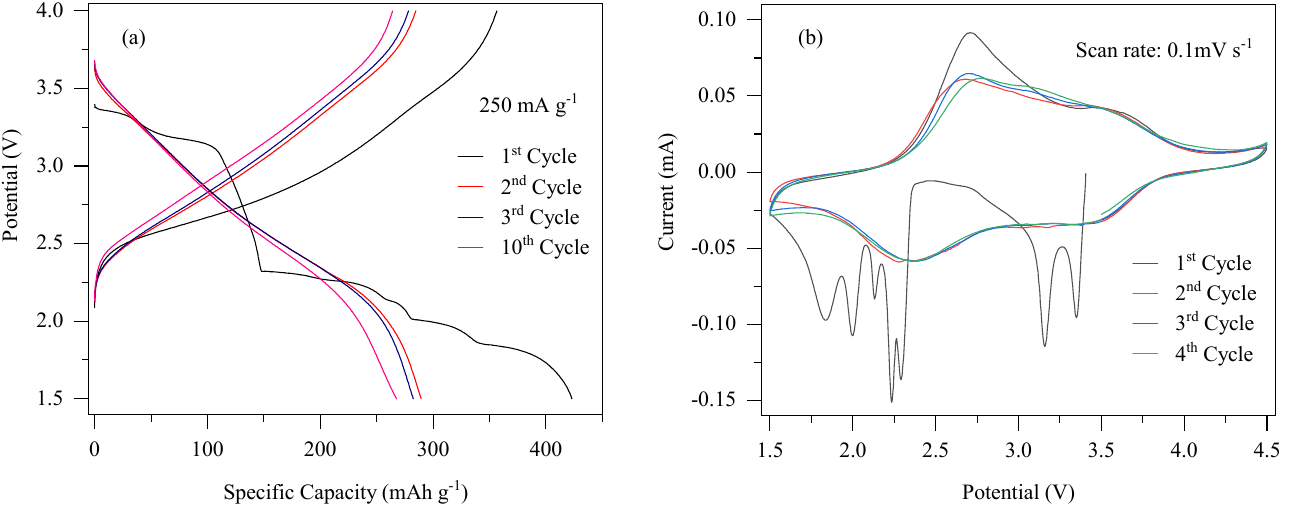
Figure 4. ( a ) Charge–discharge profile under the voltage range of 1.5–4.0 V at 250 mA g − 1 and ( b ) cyclic voltammetry curves at a scan rate of 0.1 mV s − 1 of the oval-shaped V 2 O 5 nanoparticles electrode. The cyclic voltammetry (CV) profiles of the V 2 O 5 cathode at a scan rate of 0.1 mV s −